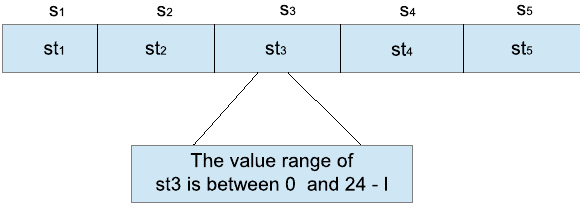
Figure 4. Flow chart of the proposed multi-objective (MO)-power scheduling problem in a smart home (PSPSH)-grey wolf optimizer (GWO) method.